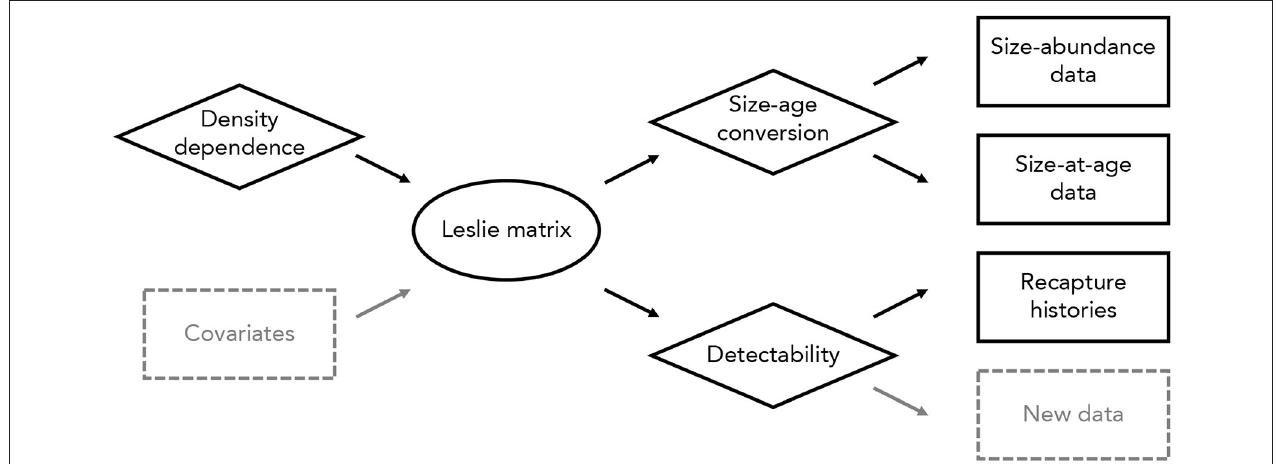
FIGURE 1 | Overview of the integrated modeling approach used here. Different data types (in rectangles) are connected to one another through a density-dependent Leslie matrix model (oval). Several sub-models (diamonds) incorporate density dependence, a conversion from sizes to ages, and detectability. New data types (dashed rectangles) could be included in this model without altering the overall modeling approach. Similarly, data and sub-models could be added or removed as needed, and the main Leslie matrix model could be replaced with an alternative process model (e.g., an integral projection model or individual-based